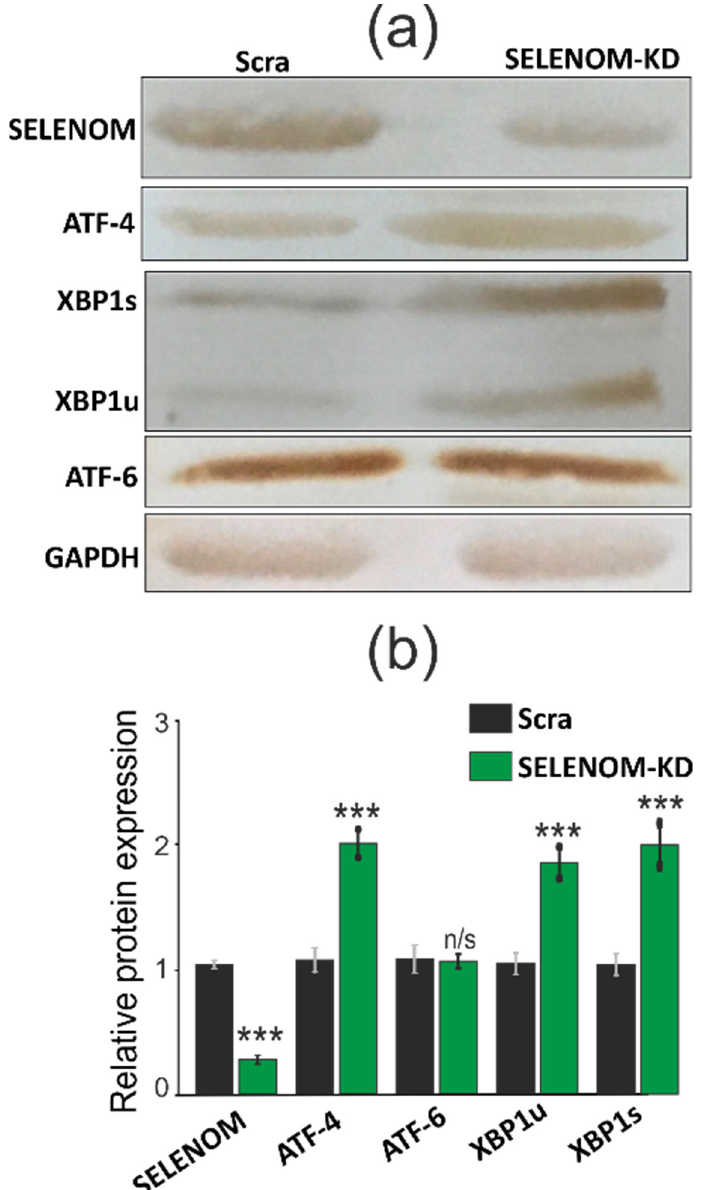
Figure 10. ( a ) Comparative analysis of the quantitative content UPR signaling pathways markers ATF-4, ATF-6, XBP1s, XPB1u in A-172 cells transduced with SELENOM-KD and scrambled RNA (Scra) under conditions of ER stress caused by 5 µg/mL SeNP using Western blotting. ( b ) Quantification of the content of ATF-4, ATF-6, XBP1s, XPB1u in A-172 cells transduced with SELENOM-KD and scrambled RNA (Scra) under conditions of ER stress caused by 5 µg/mL SeNP. Comparison of SELENOM-KD vs. Scra: n/s—data not significant ( p > 0.05), *** p < 0.001.